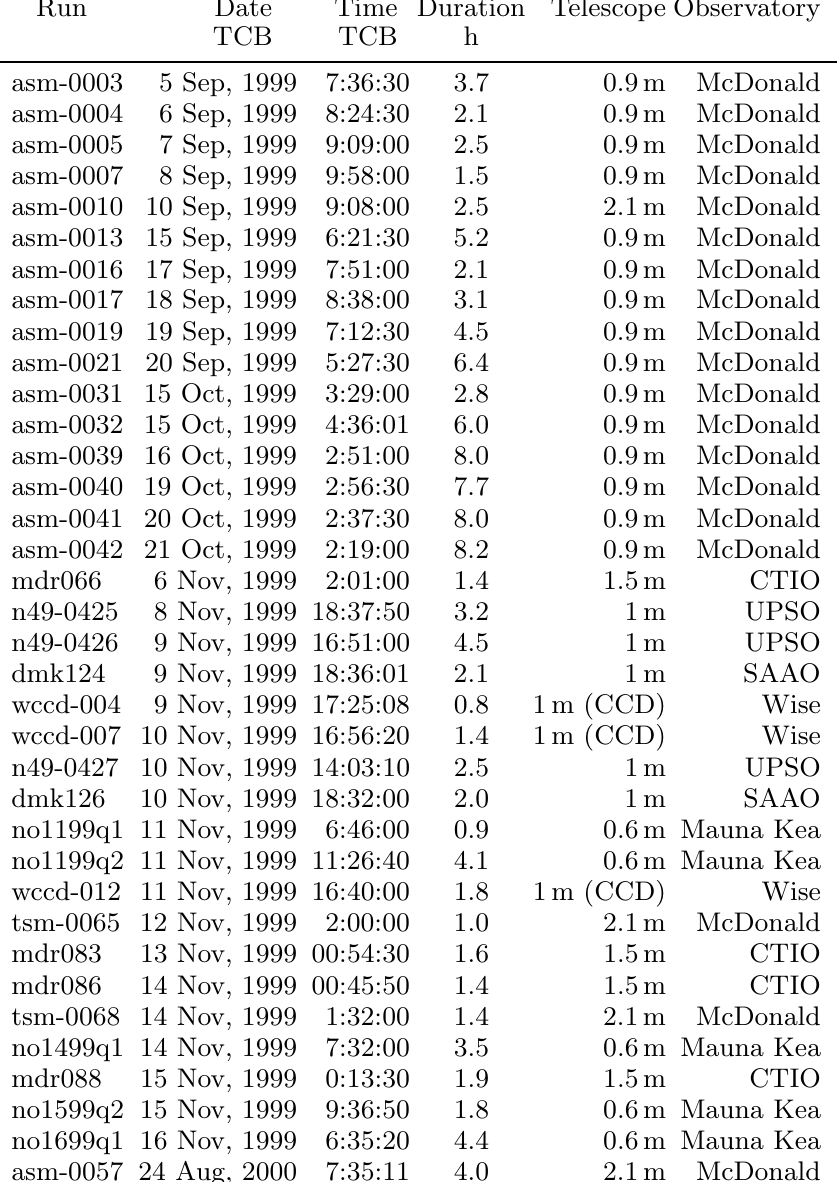
Table 1. Journal of observations for ZZ Ceti data from 1999, 2000 and